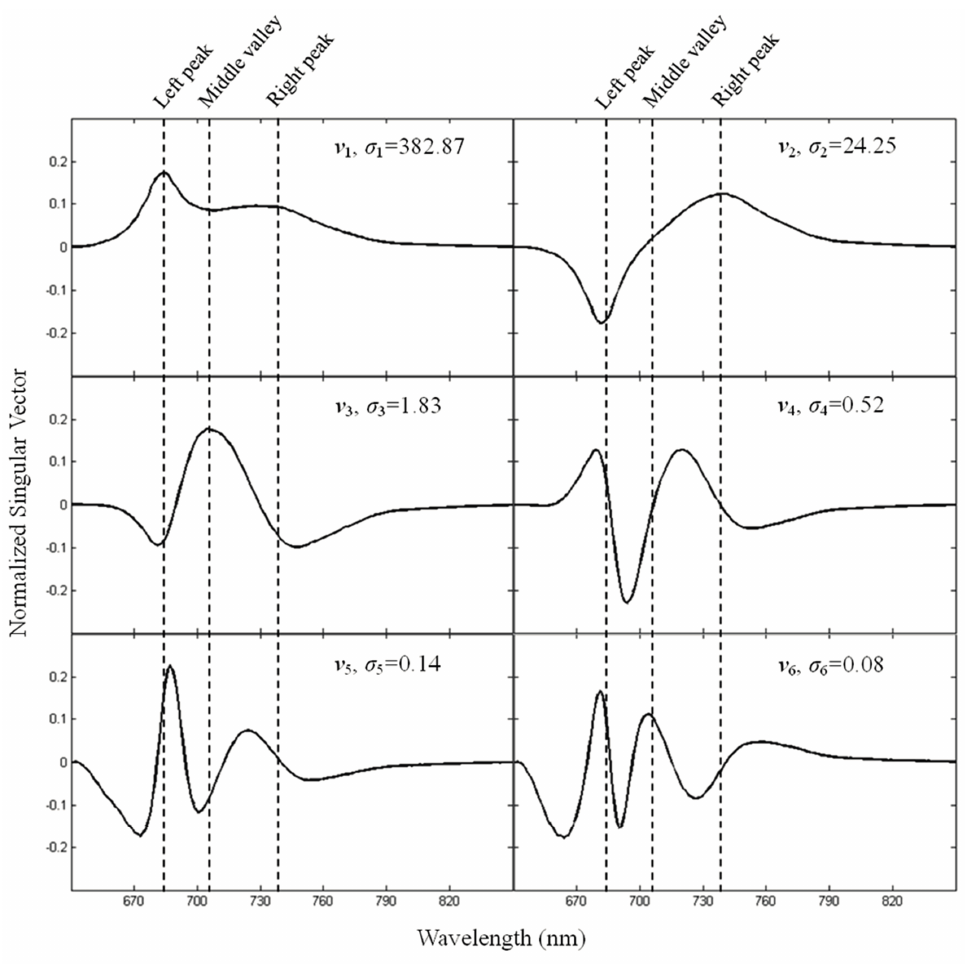
Figure 3. The first six singular vectors generated by singular vector decomposition, together with their singular values. The spectral positions of the left peak, the middle vally, and the right peak of the Fs spectrum are marked with vertical lines.